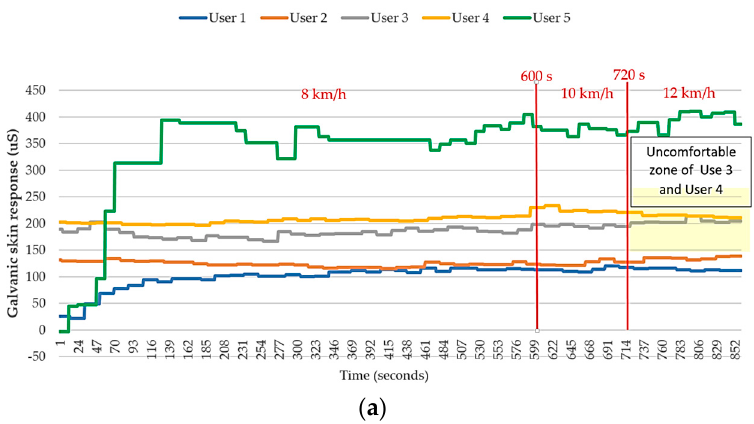
( a ) Figure 10. Cont